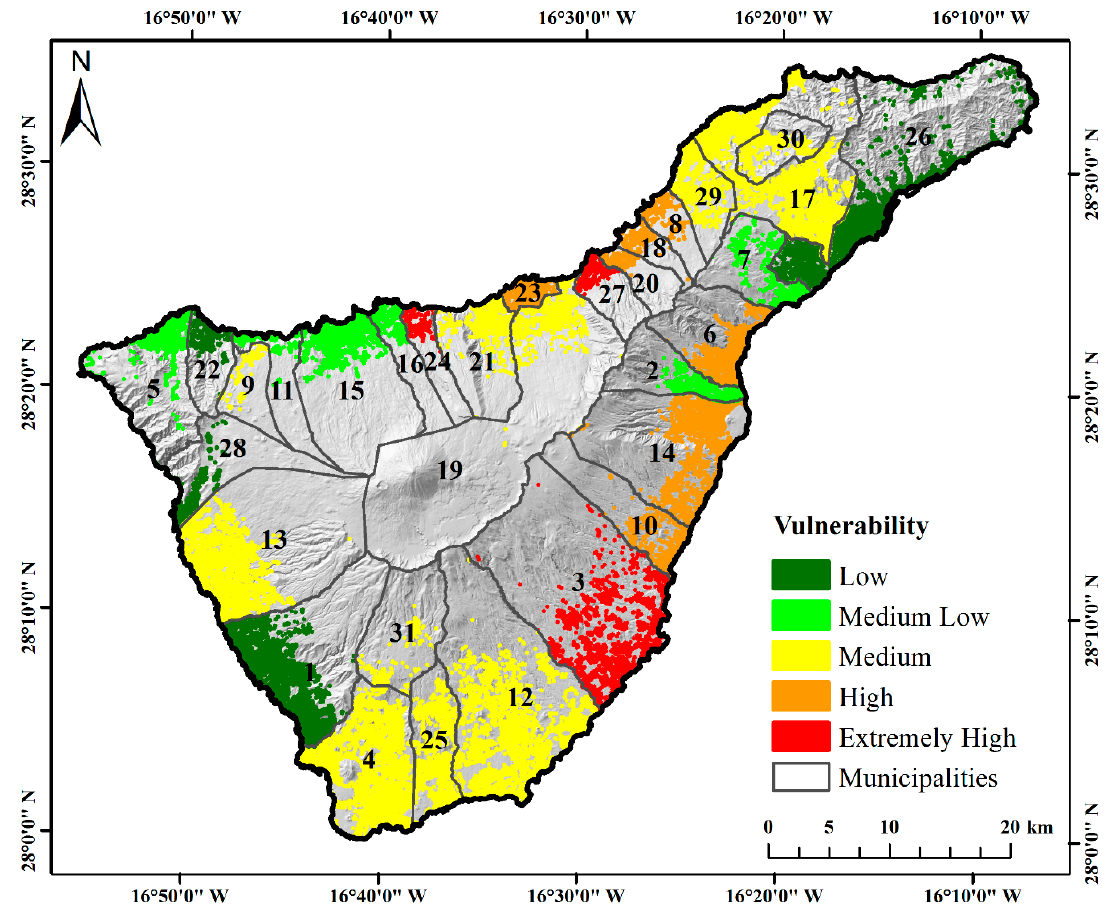
Figure 12. Vulnerability grading of Tenerife.